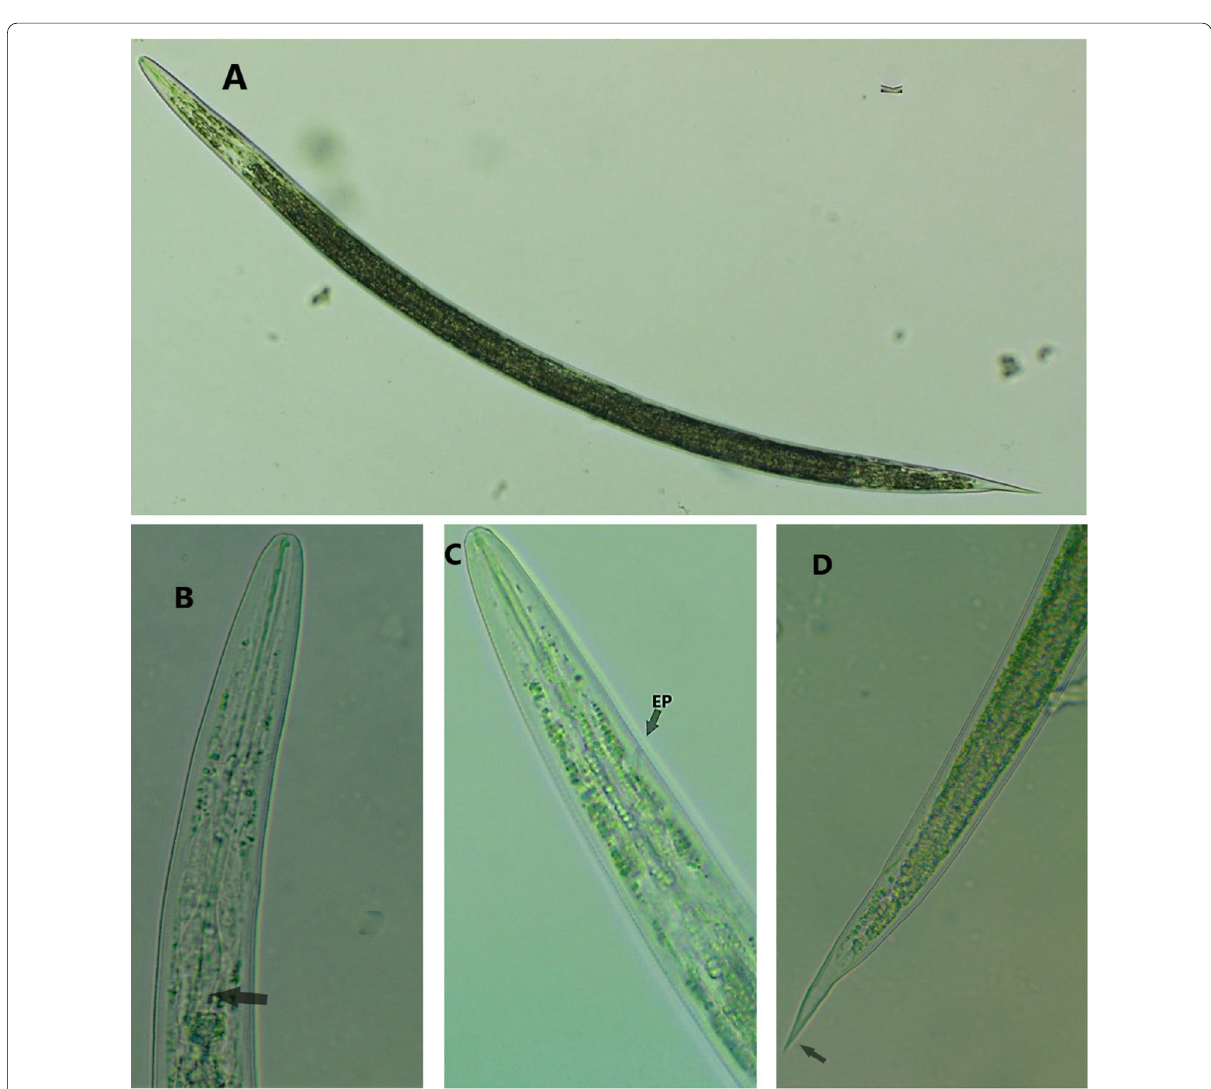
Fig. 4 S. affine infective juvenile A : infective juvenile, entire body B : anterior portion, arrow refers to basal bulb. C : anterior portion, arrow refers to excretory pore . D : arrow refers to a minute spine on tip of the tail. Scale bar A : 791 µm. B :